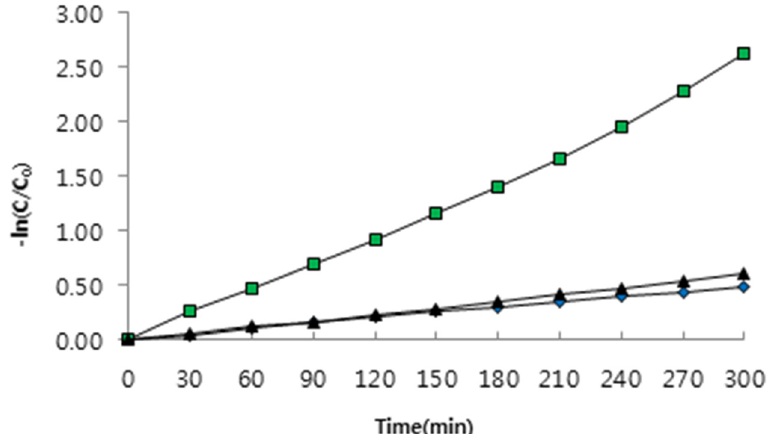
Figure 8. First-order kinetic plots of photo-degradation of MB in the presence of ZnS:Mn-MAA-pH 2 (blue), ZnS:Mn-MAA-pH 7 (green), and ZnS:Mn-MAA-pH 12 (black) NCs under the UV light